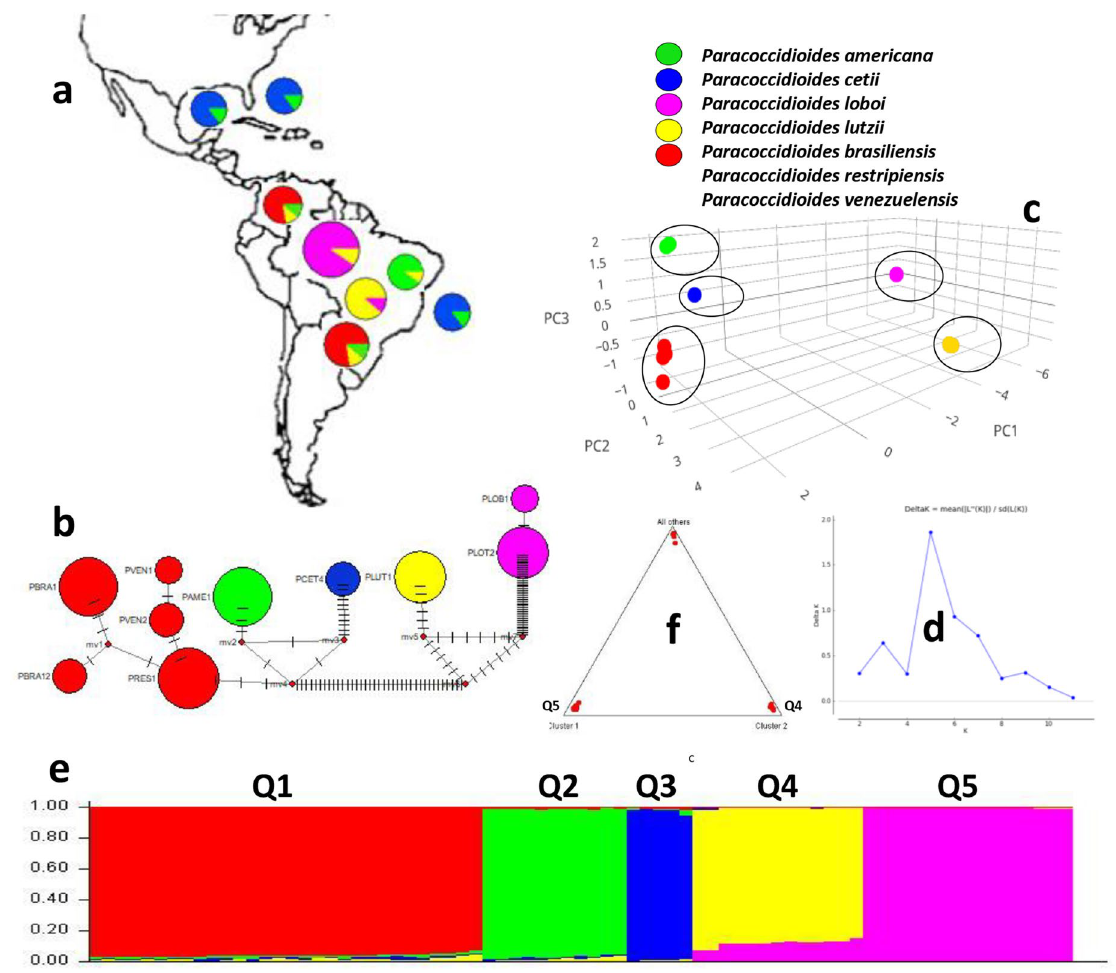
Figure 6. The concatenate Gp43 and ADP-rf data analyses was used to perform haplotypes analysis, to locate their geographical distributions ( a , b ), to estimate Principal Component Analysis (PCA) ( c ) and to investigate STRU CTU RE population distribution ( d – f ) of several Paracoccidoides species including P. cetii from dolphins and P. loboi from humans. The geographical distribution of the five haplotypes ( b ) is shown in Panel ( a ). Five clusters are observed in haplotype analysis ( b ) each corresponding to P. loboi (PLOT-pink), P. lutzii (PLUT yellow), P. cetii (PCET-blue), P. americana (PAME-green). The other Paracoccidoides species formed single haplotypes (red). Small bars between haplotypes represent mutations and the median vectors (red dots) are missing or extinct haplotypes. The size of the spheres is proportional to the number of individuals in each circle. Five-populations were also found using PCA ( c ) and STRU CTU RE ( d – f ) analyses. Panel d shows K = 5 value used to build the concatenated data. STRU CTU RE analysis ( e ) showed P. americana (Q2-green), P. cetii (Q3-blue), P. loboi (Pink-Q5) P. lutzii (yellow-Q4), and the remaining Paracoccidioides species (Q1-red) clustering in independent barplots ( e ). The numbers on the y-axis show the subgroup membership and the x-axis the different accessions (Q). The distribution of accessions into different populations is indicate by color and shape. The triangle plot ( f ) is an analogous result obtained from STRU CTU RE software outputs. The two cluster on the base of triangle corresponds to P. loboi (Q5) and P. lutzii (Q4) DNA sequences; the top harbor the remaining species in this